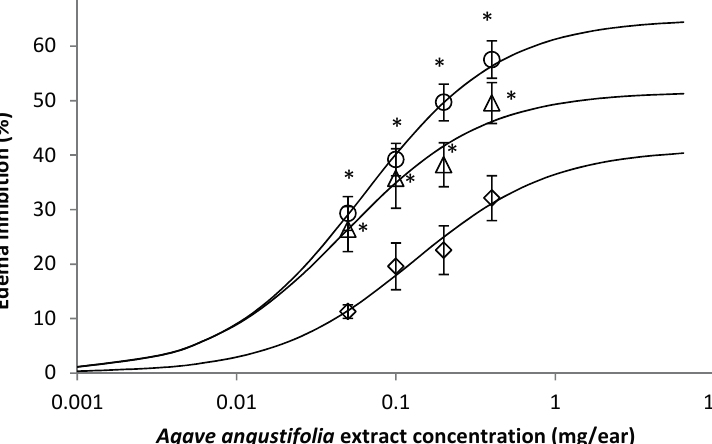
Figure 2. Concentration-response curve of extract AaAc (  ), AaF13 (mixture of β -sitosteryl glucoside and stigmasterol; ( ∆ ) and AaF16 (3-O-(6'-O-palmitoyl)- β - D -glucopyranosyl sitosterol; (  ) fractions from Agave angustifolia over edema inhibition (%), in mouse inflammation-TPA model. Dexamethasone had an anti-inflammatory effect above 80%, a result not shown. ANOVA post hoc Tukey with n = 6, * p < 0.05 when are compared with AaAc (  )